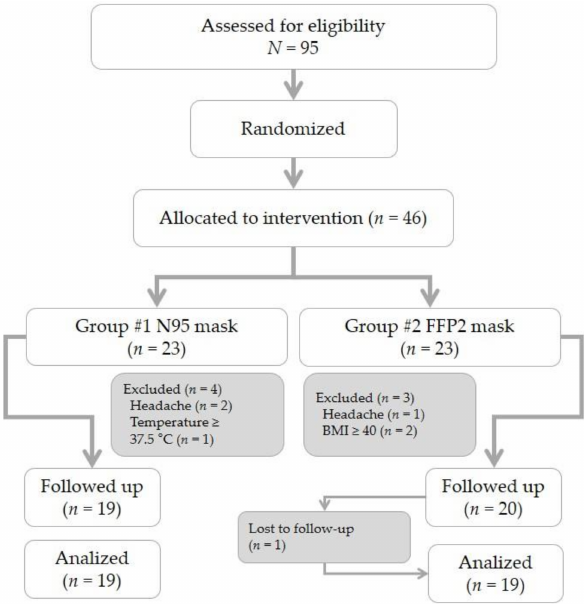
Figure 2. Flow chart of study population. FFP2: filtering